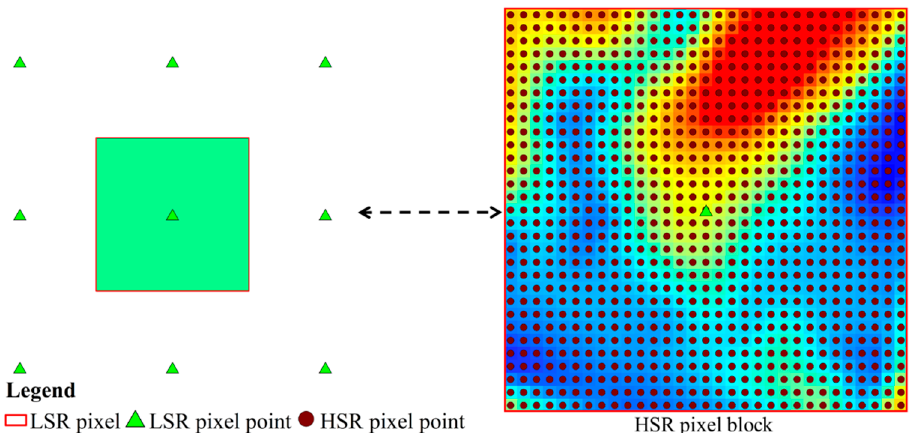
Figure 3. A schematic diagram of a low spatial resolution (LSR) pixel (green triangle) versus a block of high spatial resolution (HSR) pixels (dots with dark umber).